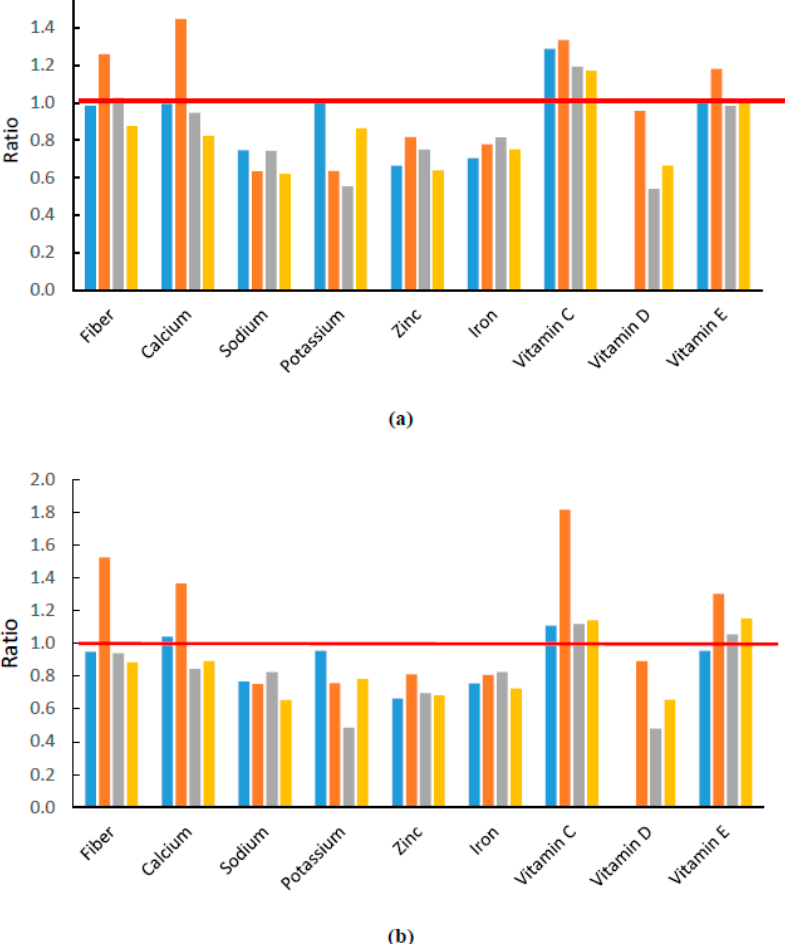
Figure 3. Nutrient density index of dietary fiber and micronutrient at snacking occasion as proportion. Panels ( a ) and ( b ) are the nutrient density index of 4–8 year-olds and 9–13 year-olds, respectively. The red line refers to a nutrient density index equal to 1. A nutrient density index greater than 1 indicates that the intake of that nutrient at snacking occasions is relatively higher than the energy contribution. Color of the bars represents different countries, blue for Australia, brown for China, grey for Mexico, and orange for the US.